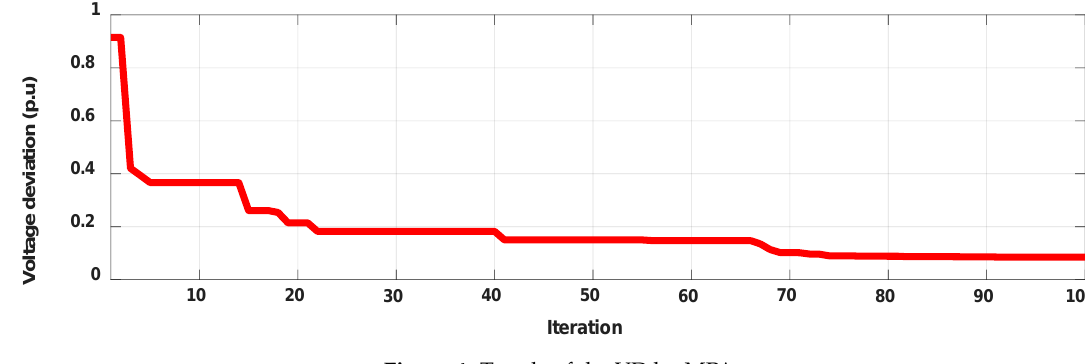
Figure 4. Trends of the VD by MPA. Table 3. Comparison of simulation results for